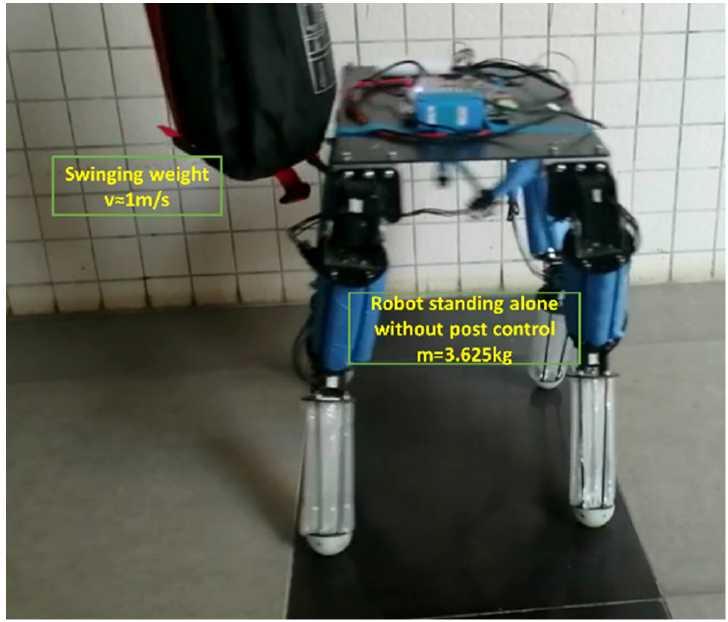
Figure 19. Stability experiment under impact of external heavy objects.